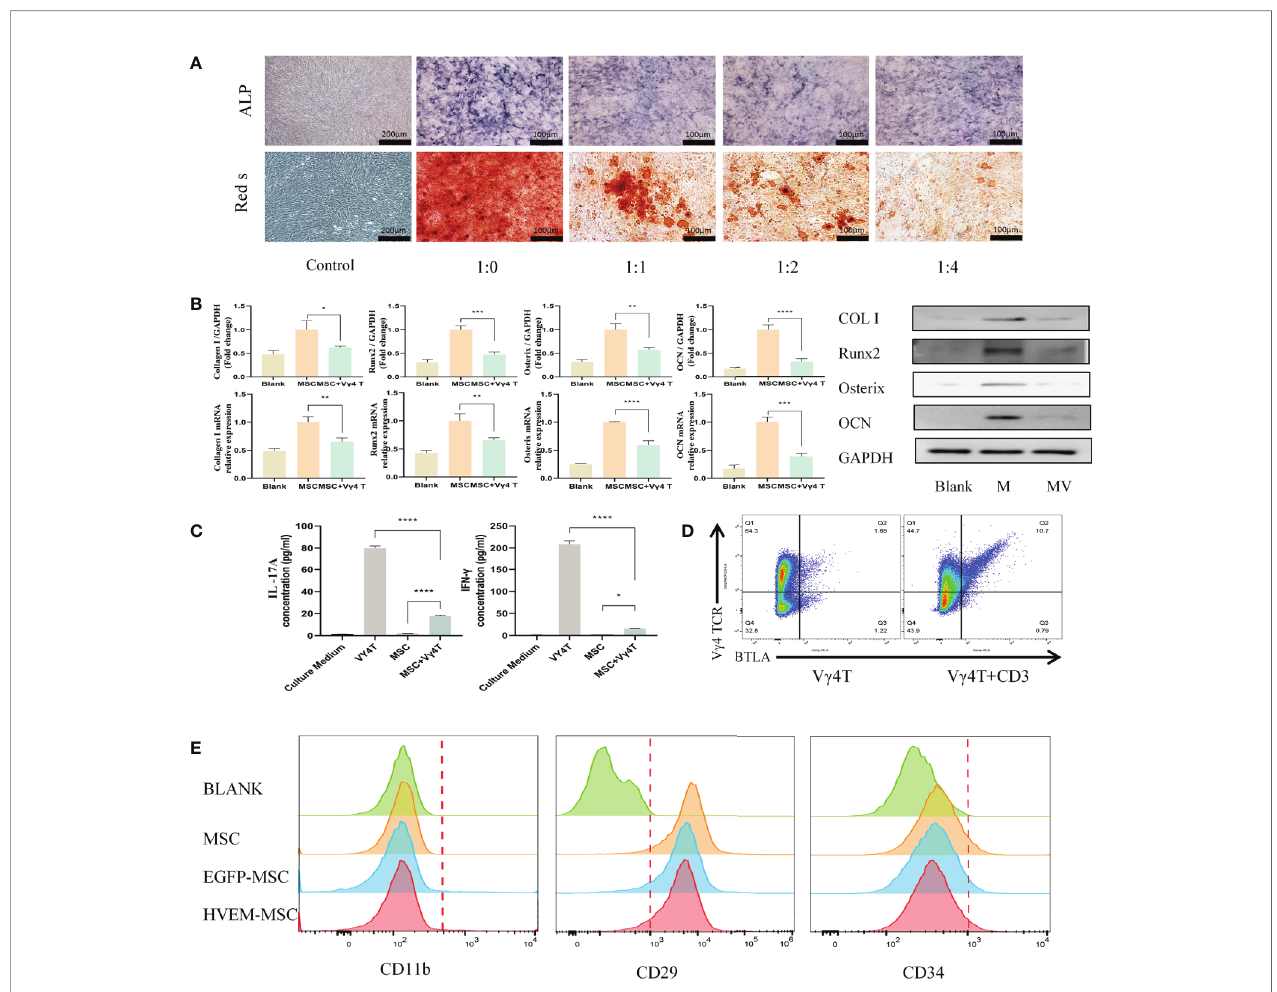
FIGURE 2 | V g 4T cells inhibite the osteogenic differentiation of MSCs. (A) ALP staining and alizarin red staining show various concentrations of V g 4T cells inhibited the osteogenic differentiation of MSCs. (B) Expression of markers of osteogenesis by MSCs with or not with V g 4T cells(the ratio is 1:4) were measured by RT- PCR and Western blotting analyses, relative protein expression of COL I, Runx2, Osterix, and OCN by Western blotting, mRNA expression levels were tested by RT- PCR. (C) The concentration of IL-17A and IFN- g was measured in the supernatant of co cultured cells for 3 days. (D) BTLA expression in V g 4T cells. (E) Changes of surface markers of MSCs or HVEM- expressing MSCs (MSCs-HVEM). Error bars represent mean ± SD. One-way ANOVA test was used to calculated P value (*P < 0.05, **P < 0.01, ***P < 0.001, ****P <